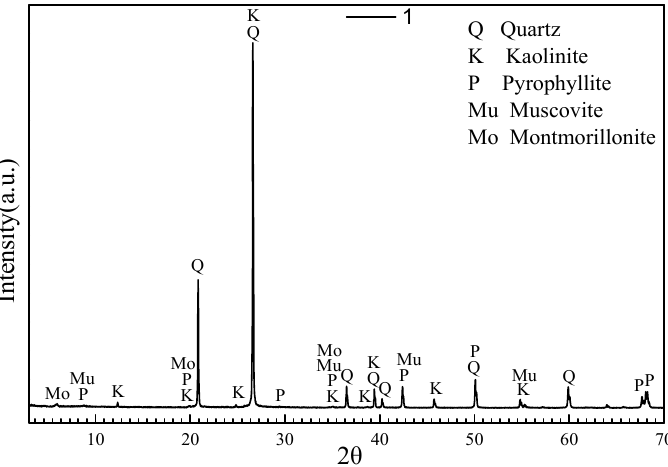
Figure 3. XRD pattern of ATWR.